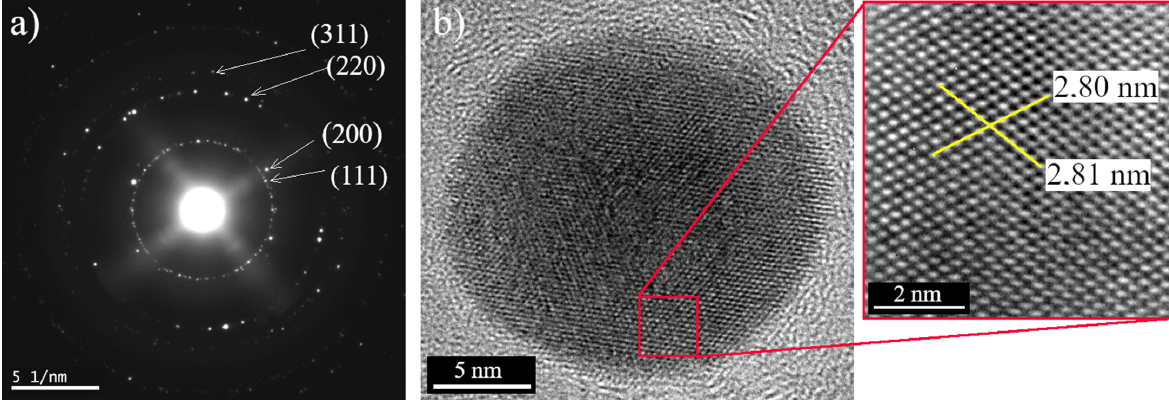
Figure 5. The electron diffraction of AgNPs ( a ); AgNPs structural lattice and lattice fringes of the synthesized AgNPs ( b ).